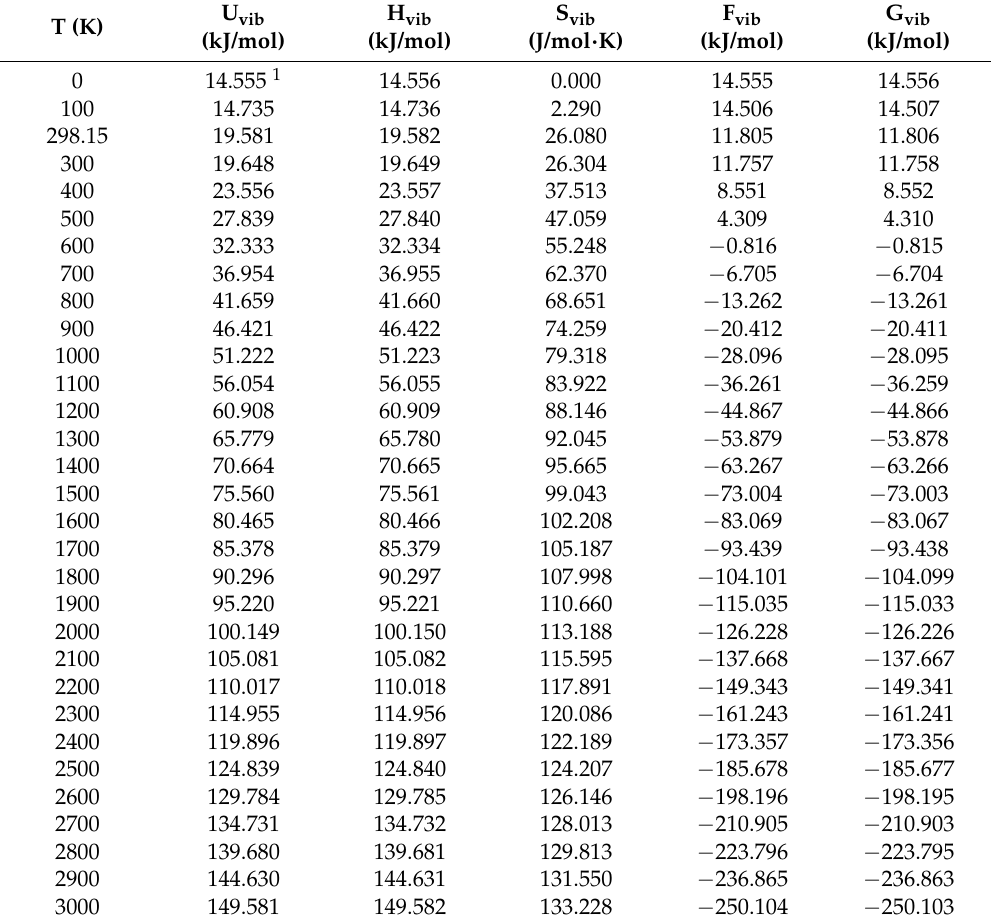
Table A2. Ab initio B3LYP vibrational contribution to thermodynamic functions of MgO at P = 1